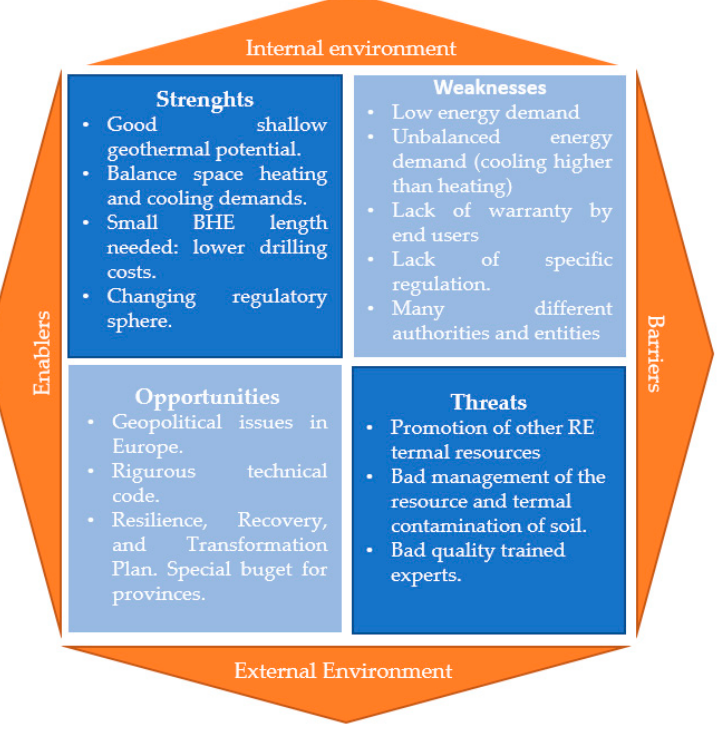
Figure 6. SWOT for the SGE and GSHP system technology in the Region of Murcia, Spain compared to Munich, Germany.